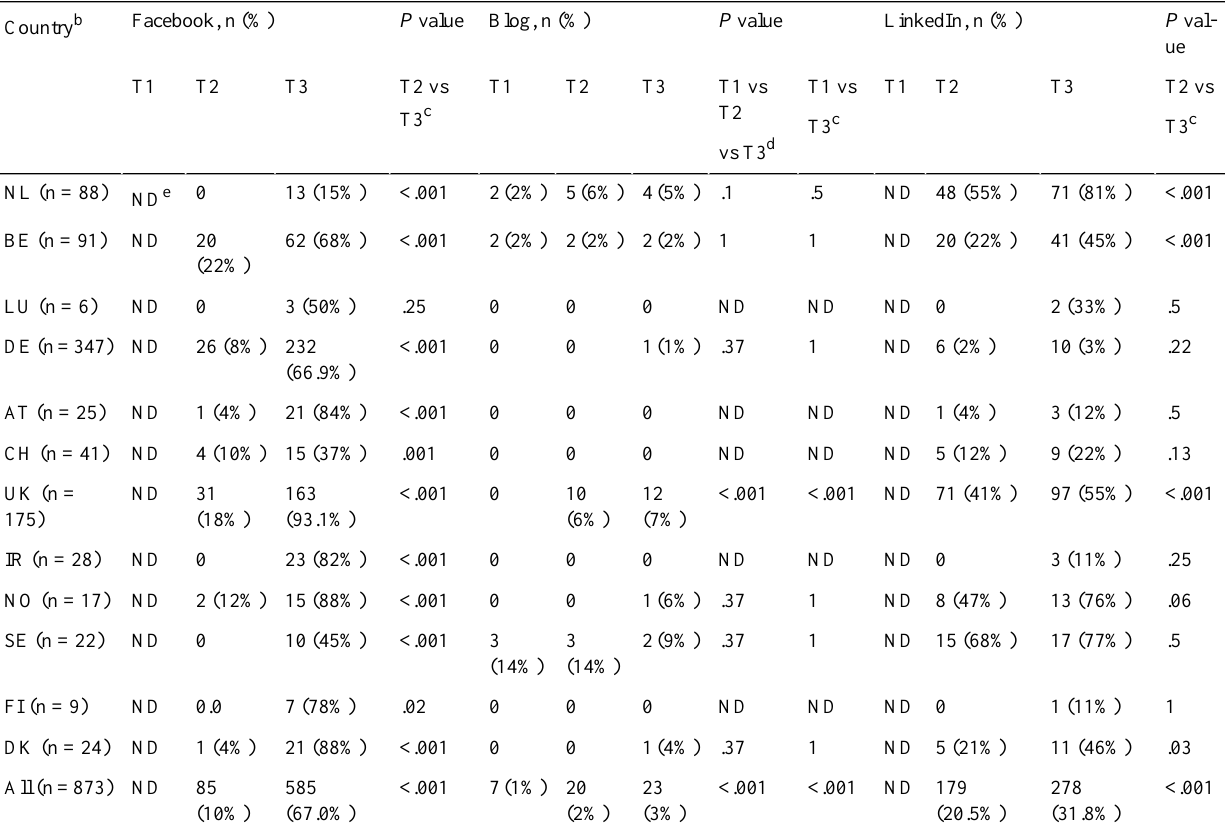
Table 4. Social media usage (T1–T3) a in 12 Western European countries (Facebook, blogs, and